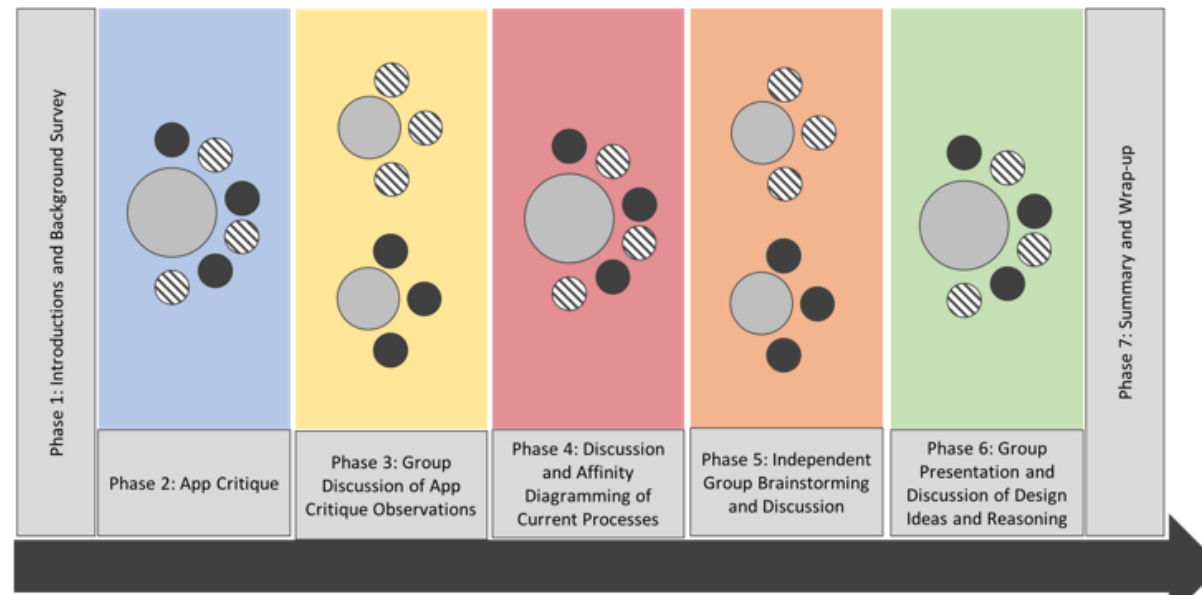
Figure 1. Diagram outlining the flow of the participatory design